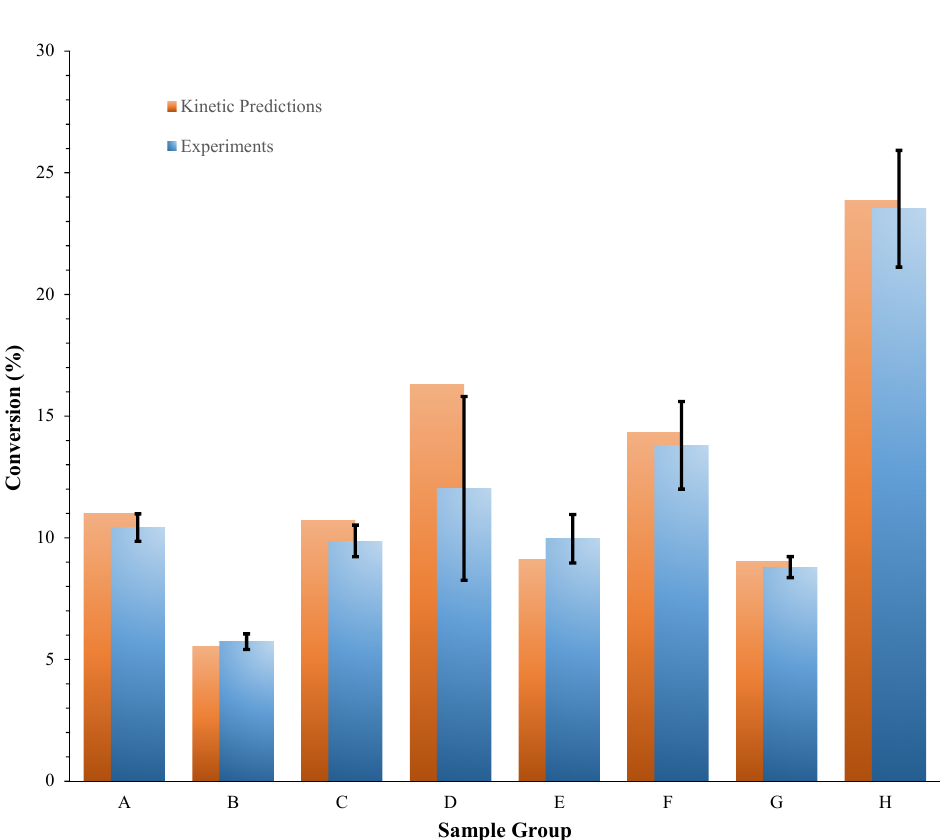
Figure 8. Conversions of PA evaluated using HPLC analysis for the different sample groups of Table 5 and the corresponding kinetic predictions.